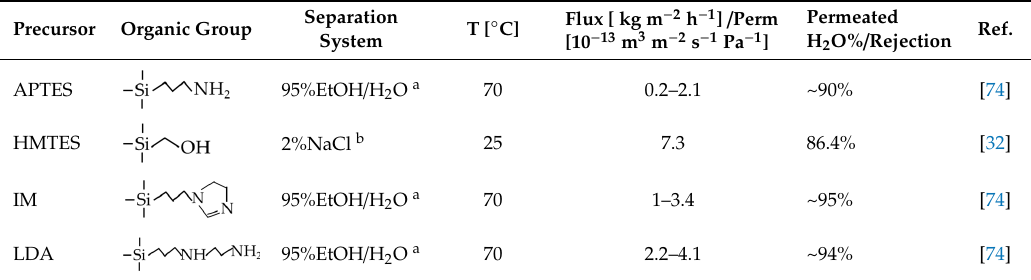
Table 5. Pendant-organosilica membranes and their performance in liquid-phase separation.